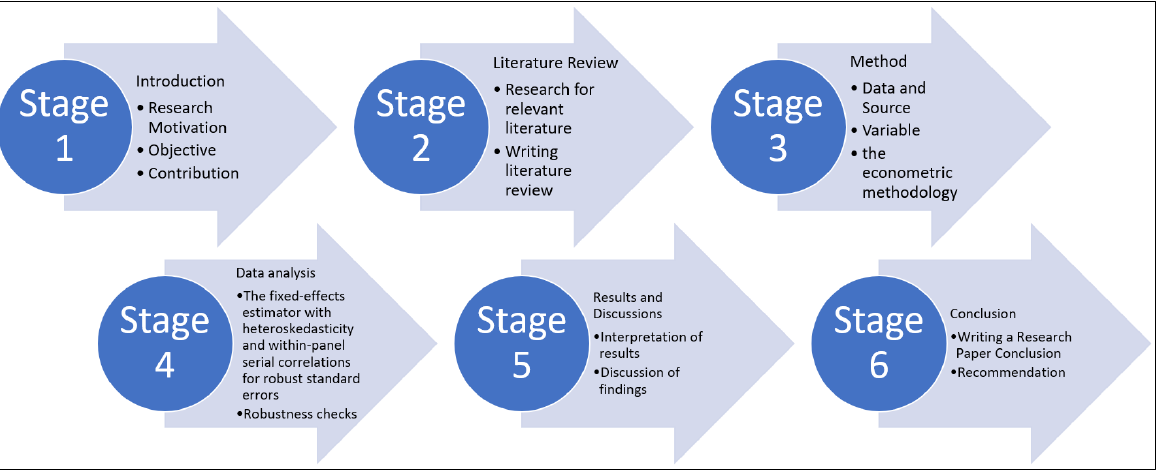
Figure 2. Research